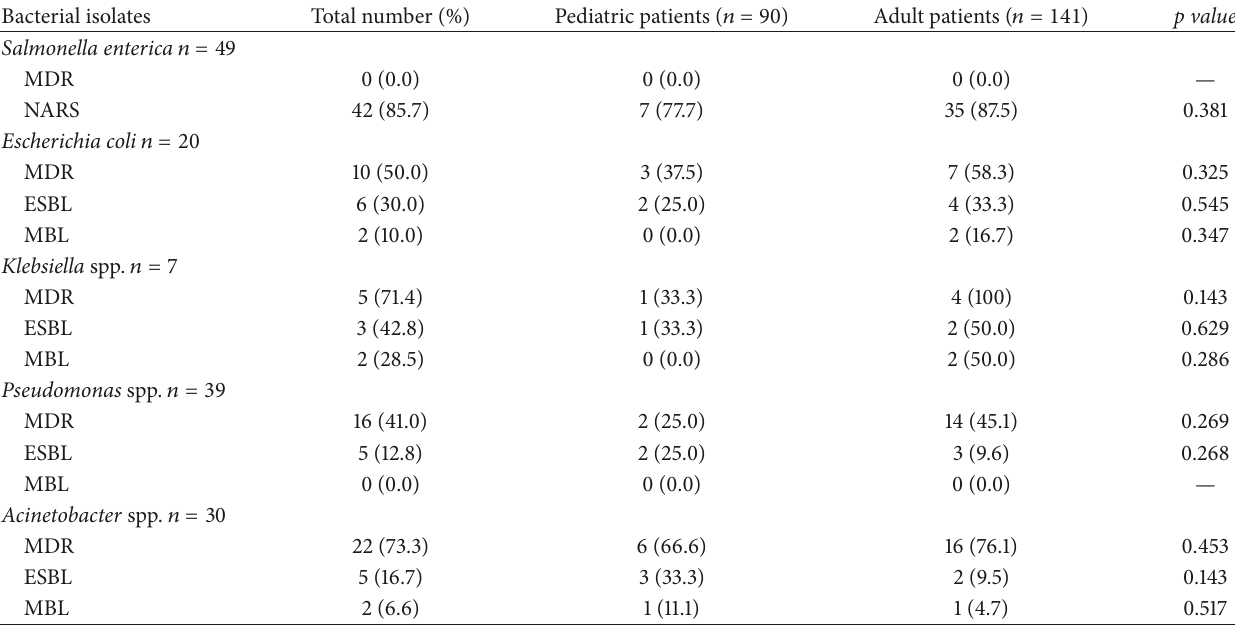
Table 7: Trends of antimicrobial resistance mechanisms in gram negative isolates among pediatric and adult patients ( 𝑛 = 231 ). Bacterial isolates